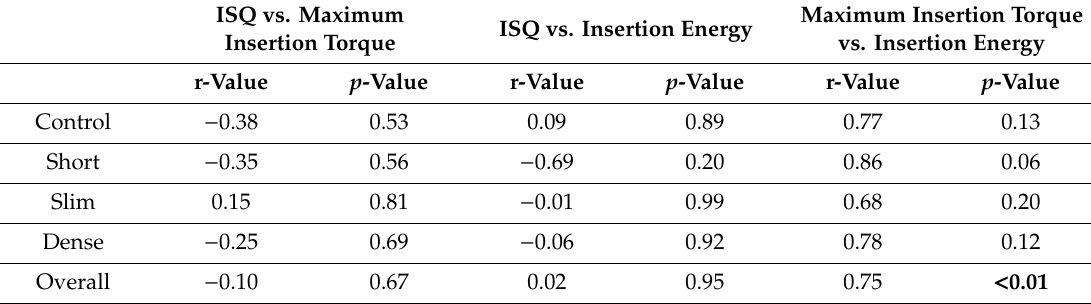
Table 4. Pearson product moment correlation for the parameters implant stability quotient (ISQ,) maximum insertion torque and insertion energy ( α = 0.05; significant correlations are written in bold). ISQ vs. Maximum ISQ vs. Insertion